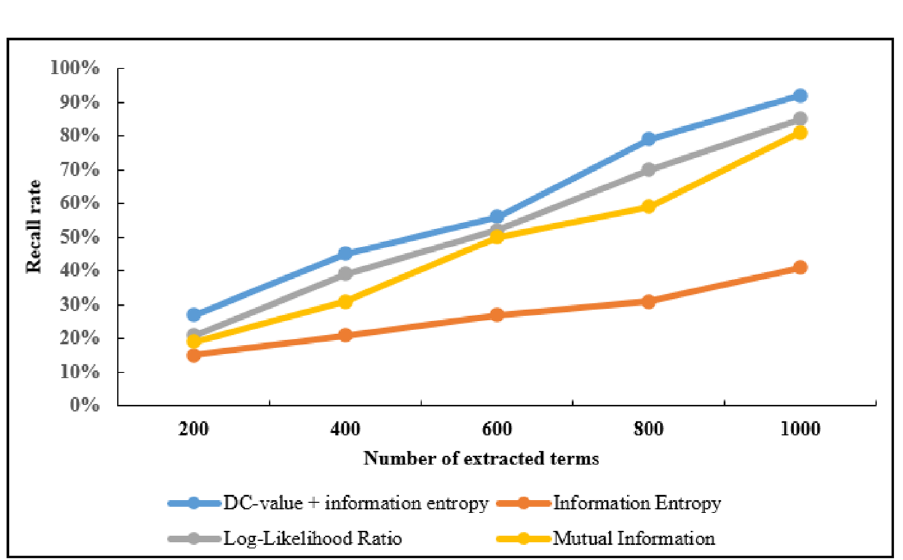
Figure 5. Recall rate comparison of extraction